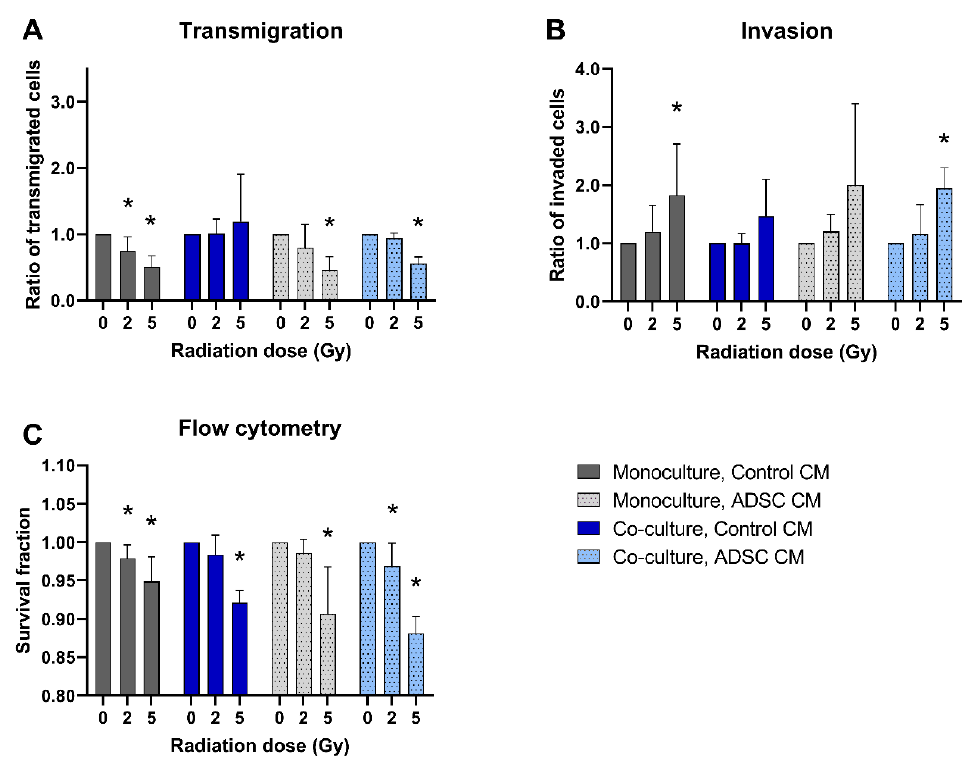
Figure 3. Effect of radiation on the transmigration ( A ), invasion ( B ), and cell survival ( C ) of MCF-10A cells compared to non-irradiated cells. MCF-10A cells were cultured as mono- or co-culture with fibroblasts; irradiated with 0, 2, or 5 Gy, and treated either with adipose-derived stem cell conditioned medium (ADSC CM) or control CM. Irradiation with 0 Gy was set 1 for each group. ( A – C ) Columns show the ratio of transmigrated cells ( A ), invaded cells ( B ), and the percentage of live cells (C; y-axis) in varying radiation doses and for mono- and co-cultured cells treated with ADSC CM or control CM (x-axis). n = 3 replicate experiments, and values are presented as mean ± SD. *: p < 0.05, and 5 Gy and 2 Gy were compared to 0 Gy (Mann–Whitney U-test).